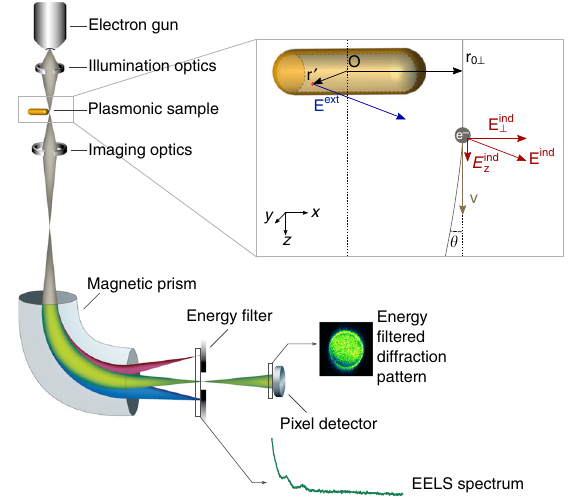
Fig. 1 IMT setup. By using an energy fi lter, the angular distribution of the inelastically scattered electrons in the far fi eld is recorded for a fi xed energy loss. The CoM of that signal corresponds to the IMT, whereas the integral represents energy-loss probability for that energy